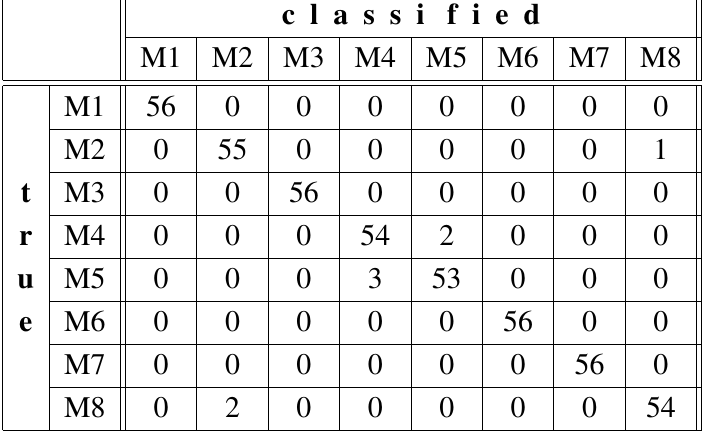
Table 7. Confusion matrix for RBA (LOO cross validation, 95.1%).